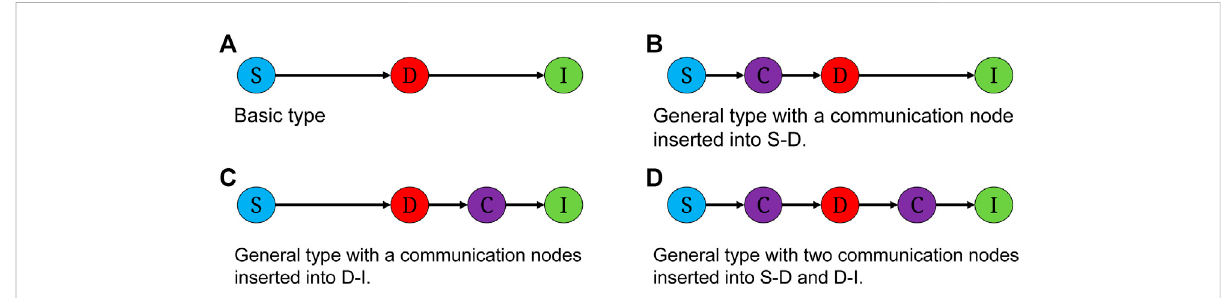
FIGURE 2 Heterogeneous operational chain. As shown in Figure, the OC can be divided into basic type and general type. The basic type, as shown in (A) , consists of sensor operation unit, decision operation unit and in fl uence operation unit directly connected. Since any combat unit can also act as an intermediary for information transfer, we extend the basic type to a general type with mediated communication nodes, i.e., (C) .Considering the timeliness of operational information, we only consider here the case where there is a one-hop intermediary in the SD and DI information transfer process, and the general type of OC is shown in (B – D) .